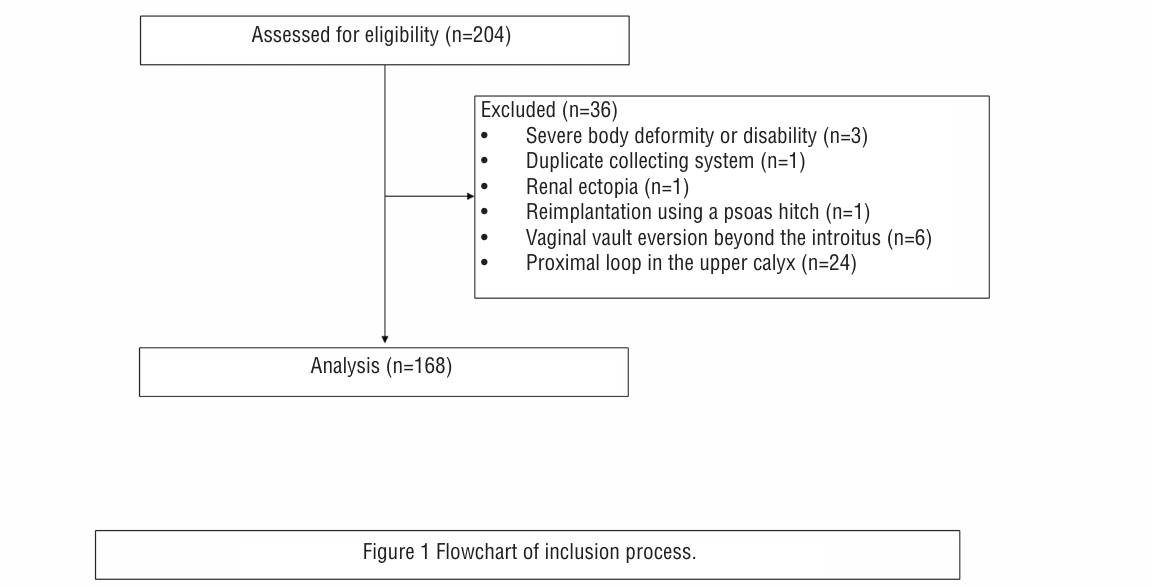
Figure 1 - Flowchart of inclusion process.